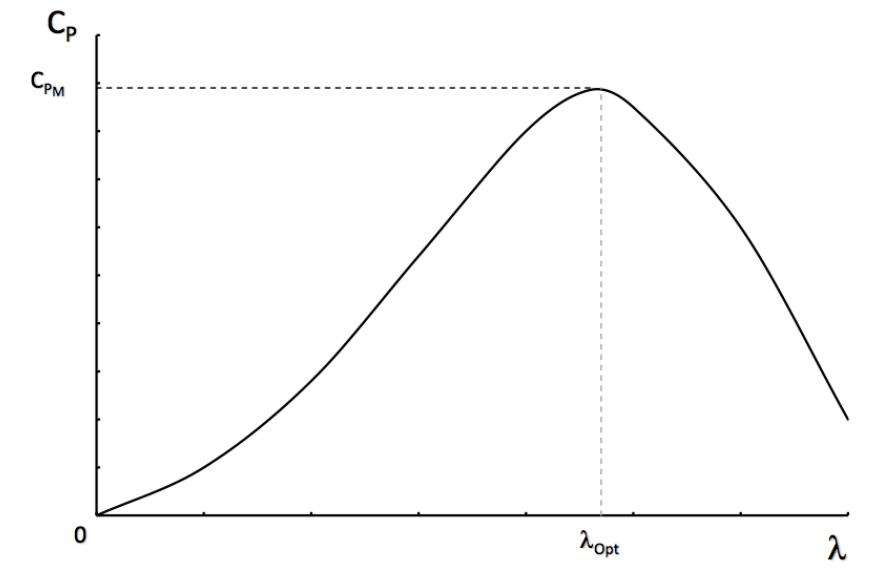
Figure 2. The power coefficient C P as a function of the tip speed ratio λ